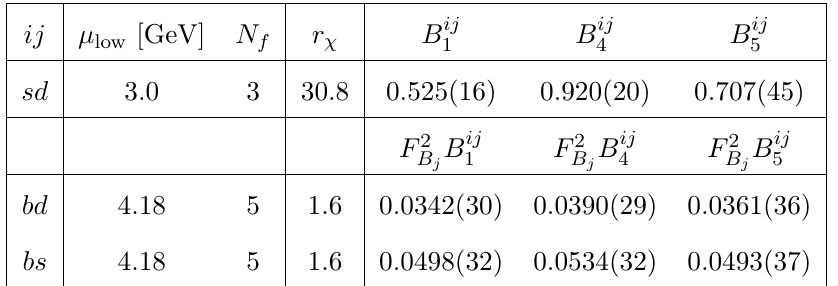
Table 14. Scale settings and number of (cid:13)avours, N f , as well as numerical inputs of bag factors entering M ij , see [61] and [140] for correlations. For the Kaon system threshold crossings to 12 N f = 4 and N f = 3 have been chosen as 4 : 18 GeV and 1 : 4 GeV. The chirality-factor is given as r ij = ( M M = ( m i ( (cid:22) low ) + m j ( (cid:22) low )) 2 . See also [18] for more details on M ij (cid:31) ij Open